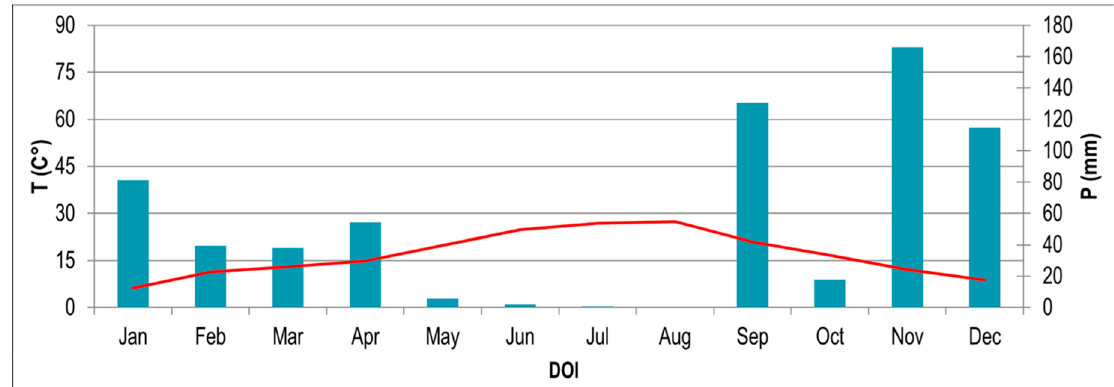
Figure 1. Climatic diagram of monthly mean temperatures (T, red line) and total precipitation (P, blue bars) for 2017 according to data recorded at the Sant’Anastasia meteorological station.